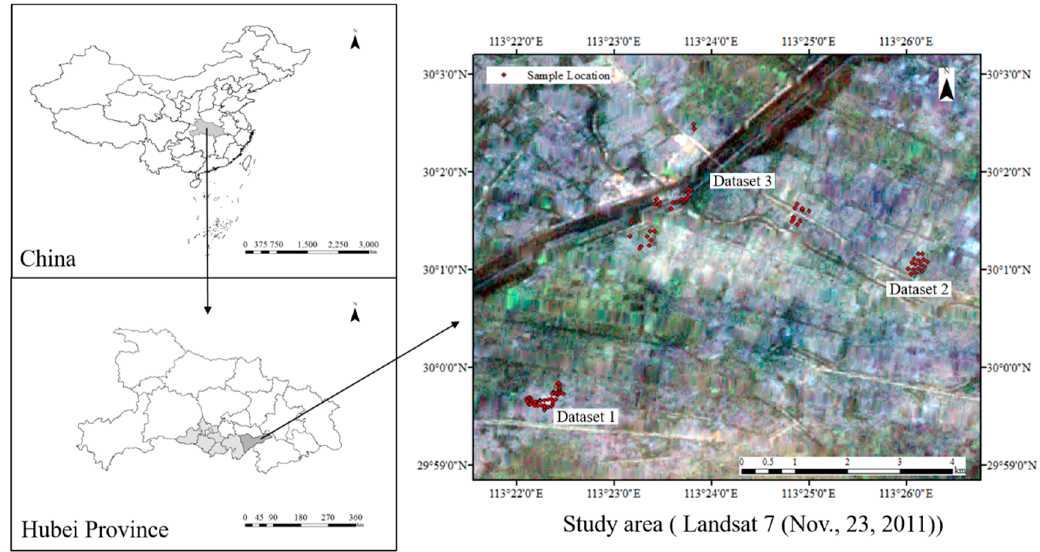
Figure 1. Location of the study area and soil sampling.